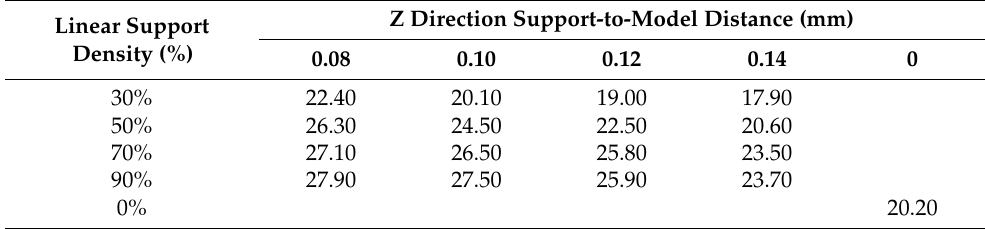
Table 2. Average compressive strength (MPa) of experimental parts with different influencing factors under linear support conditions.